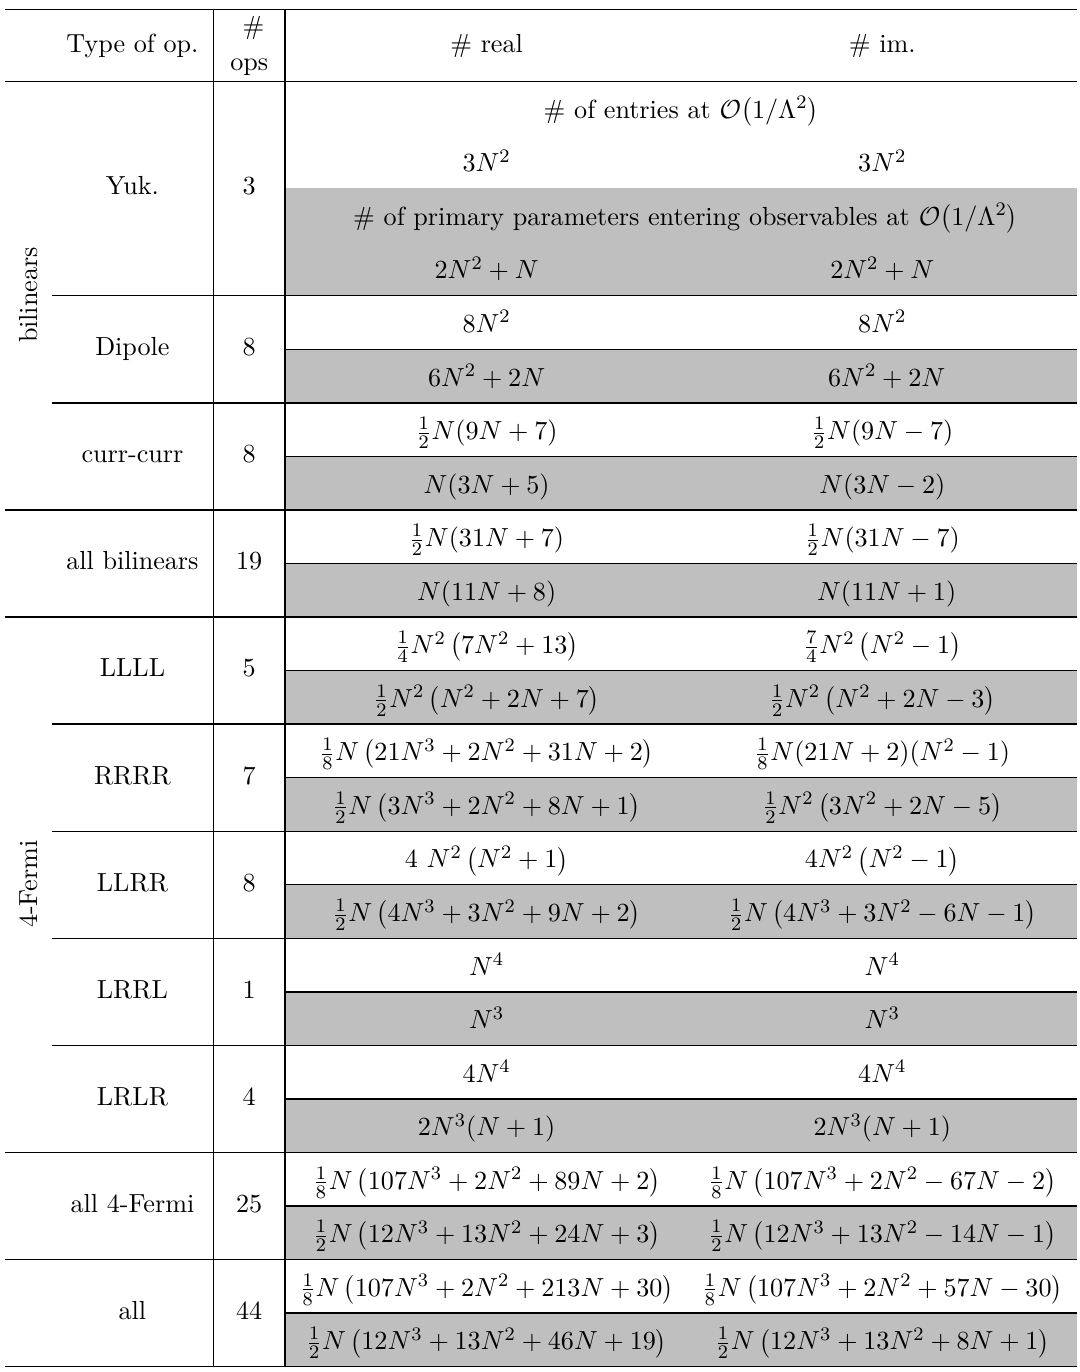
Table 9 . Number of flavorful real and imaginary parameters in SMEFT at dimension-six with N flavors. For each type of operator, the first line (in white) counts the number of physical parameters, while the second one (highlighted in gray) counts those which are also